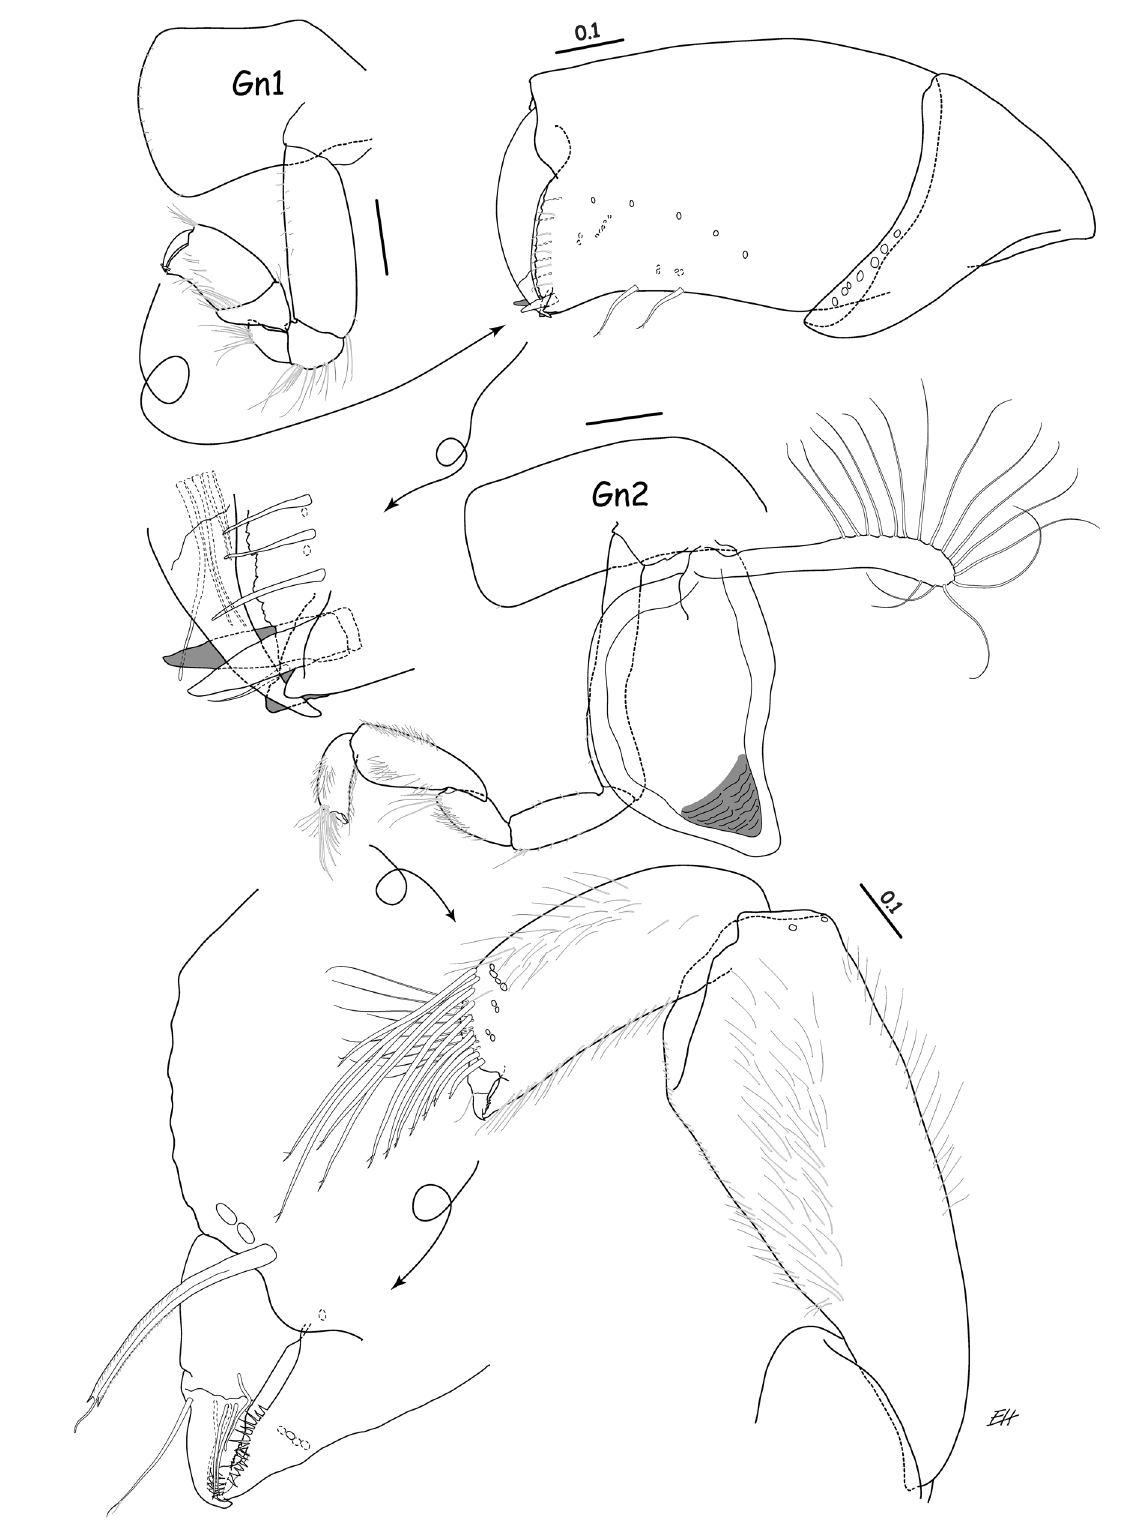
Fig. 3. Abyssorchomene abyssorum (Stebbing, 1888), ♀, 9.5 mm (ZMH K-61206). Rows of pectinate setae omitted on propodus of Gn2 detail. Scale bars = 0.5 mm unless indicated